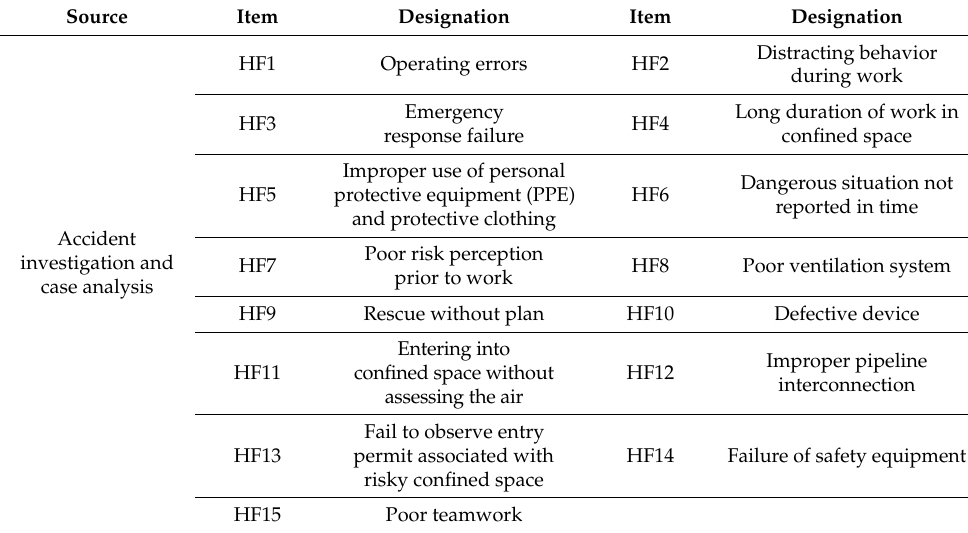
Table 1. Source of human factors and their corresponding